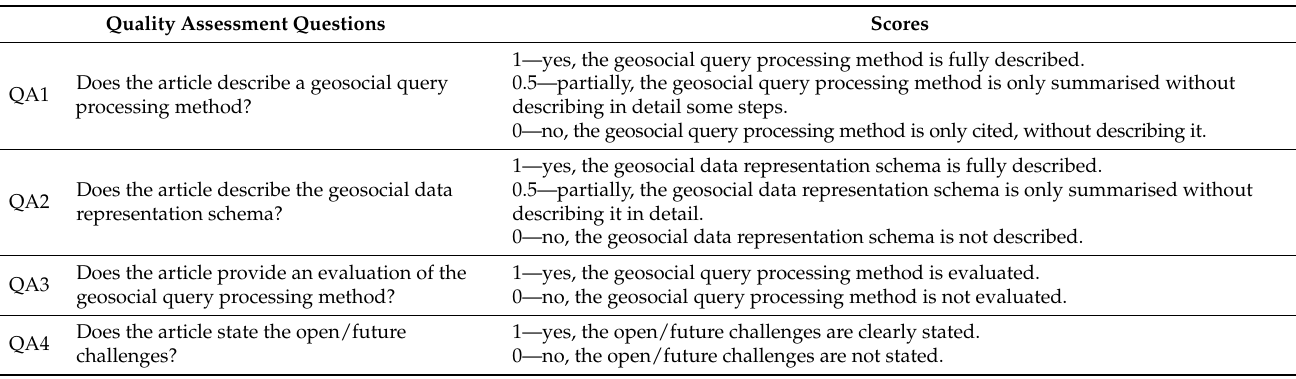
Table 4. Quality assessment questions and scores formulated for the study.